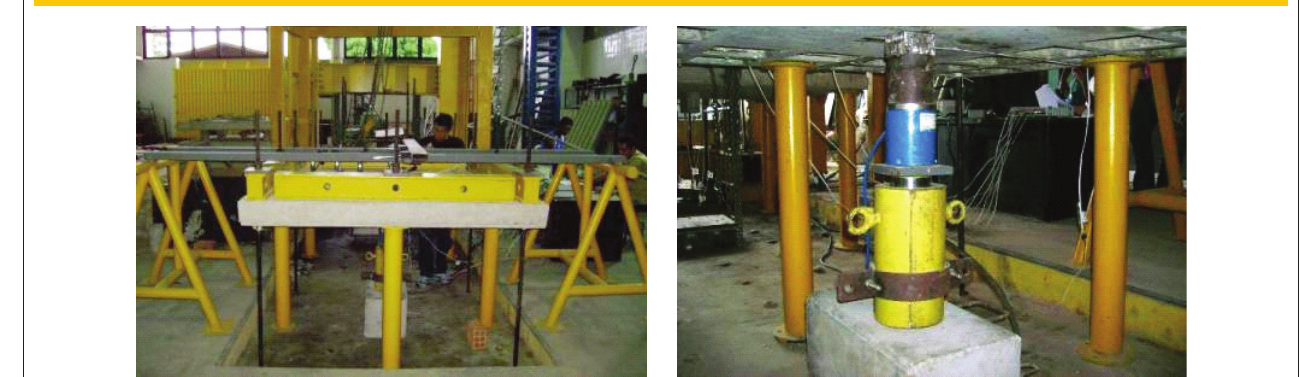
Figure 10 – Details of the loading